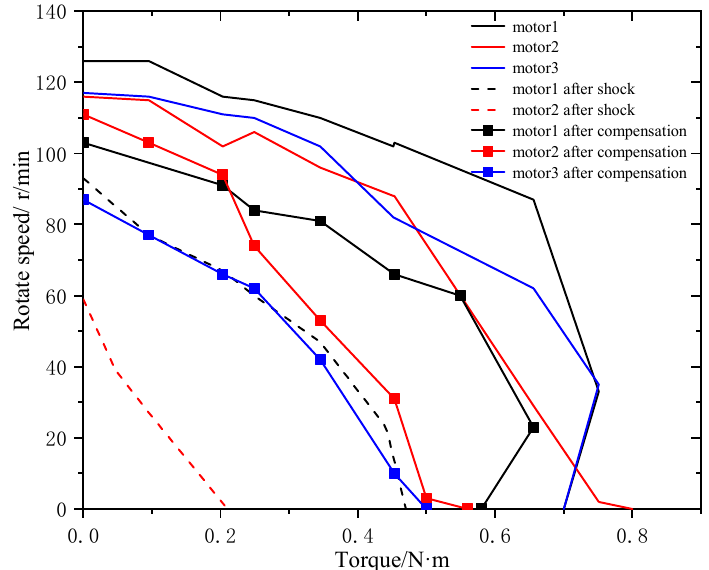
Figure 10. Performance of motors before and after impact and compensation.